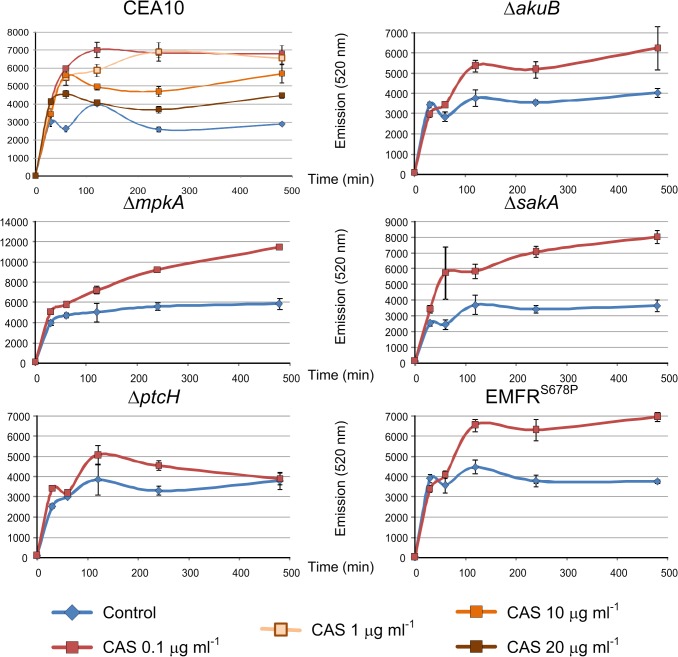
Effects of caspofungin on membrane efflux.Transporter-mediated efflux of rhodamine 123 was determined in absence (blue line) and presence of caspofungin (red line). The wild-type CEA10 strain was challenged with different caspofungin concentrations, while the mutant strains were analyzed using only a caspofungin sub-lethal concentration (0.1 μg ml-1). For each sample, cytosolic content was extracted and measured (excitation/ emission 480/520 nm) at the reported time points. ± Standard error of the mean.